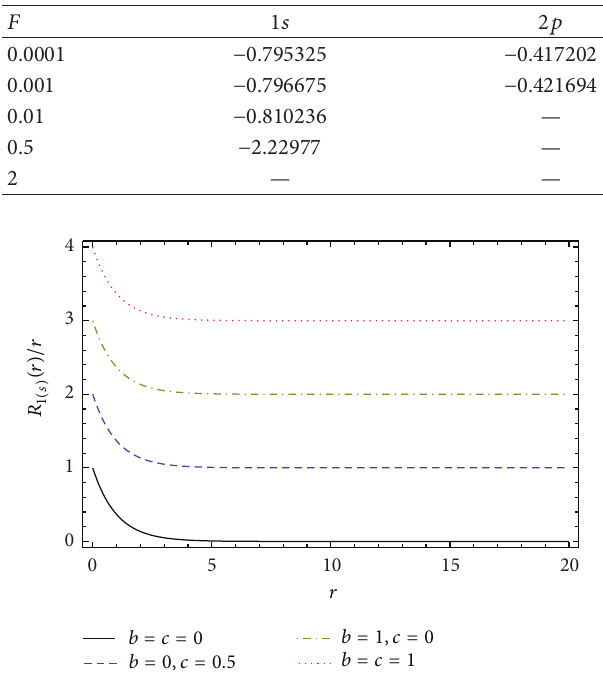
Figure 6: When 𝜆 = 500 , plot of wave functions of 1𝑠 state for different cases of 𝑏 and 𝑐 screening parameters (in arbitrary units).